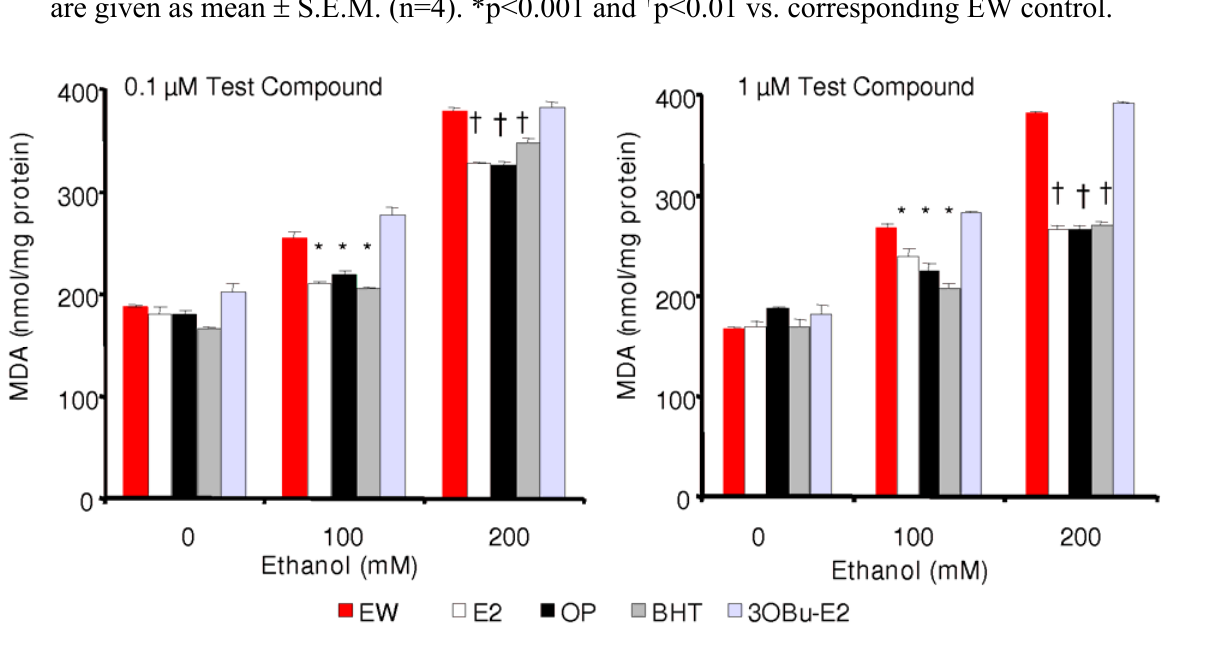
Figure 4. Effect of E2, OP, BHT and 3OBu-E2 on EW-induced lipid peroxidation. Data are given as mean ± S.E.M. (n=4). *p<0.001 and † p<0.01 vs. corresponding EW control.